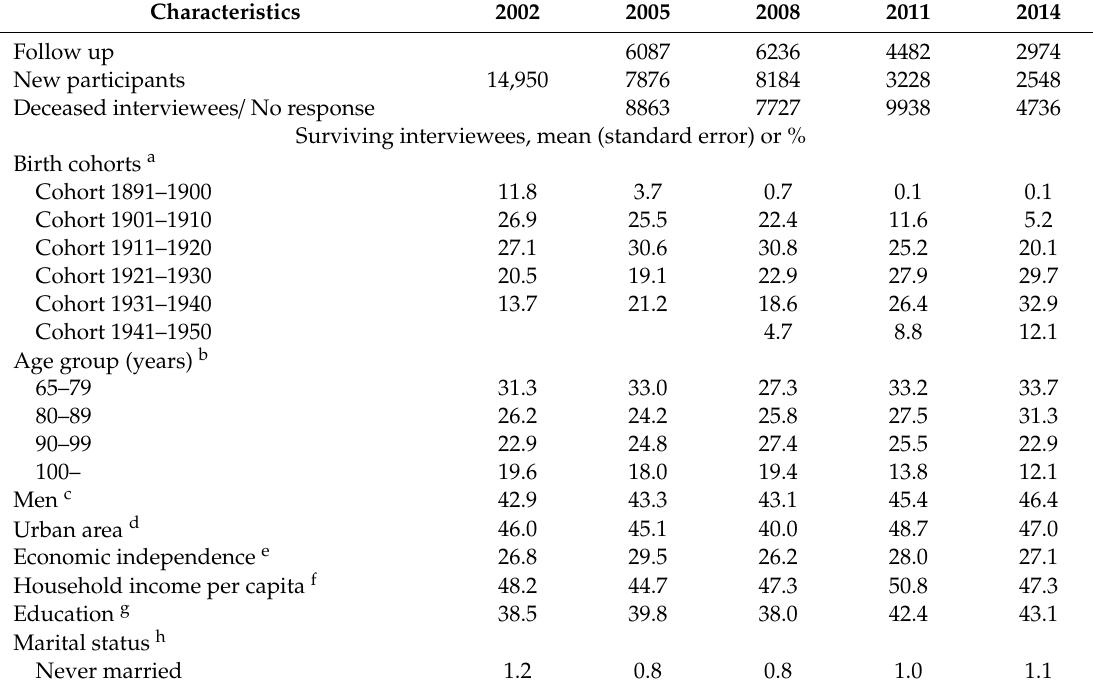
Table 1. Sample distribution and demographic characteristics of older adults -